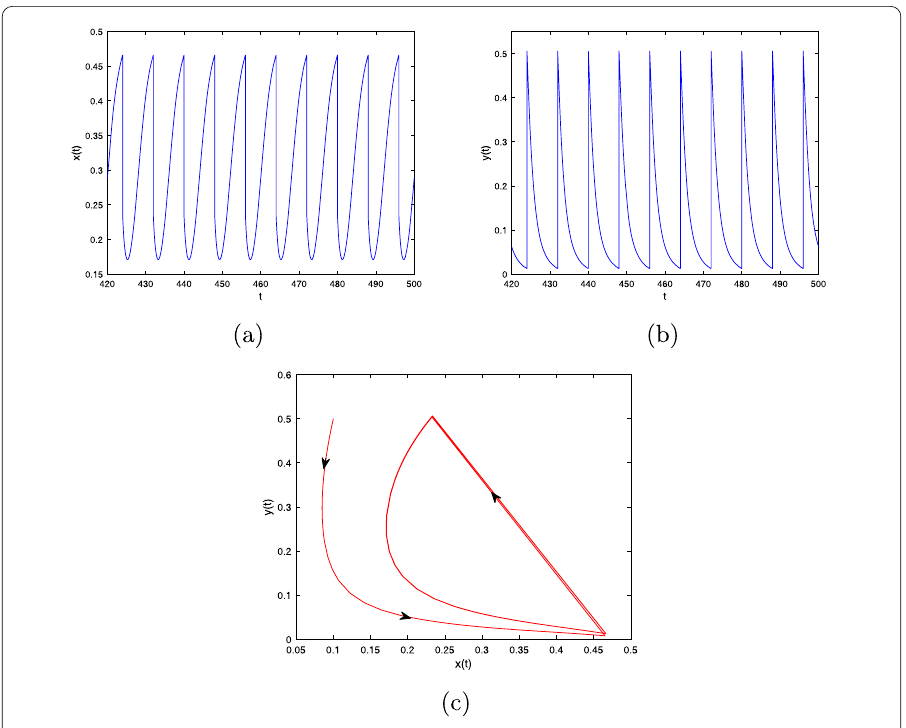
( a ) the bounded time series simulation of the prey density x ( t ); ( b ) the bounded time series simulation of the predator density y ( t ); ( c ) the trajectory simulation projected on the xy